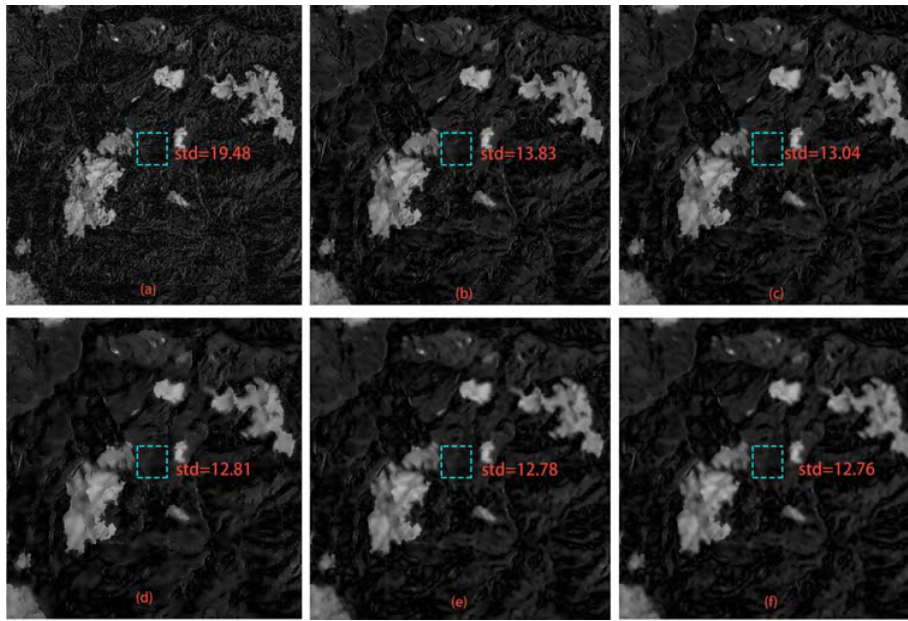
Figure 3. Change Magnitude Image Comparisons between the Image Difference and The Proposed Approach: ( a ) is the CMI obtained by image difference method; ( b – f ) are the CMIs obtained by the proposed approach with a fixed T 2 = 50. T 1 is equal to 30, 40, 50, 60, and 70 for each sub ‐ figure from ( b ) to ( f ), respectively.